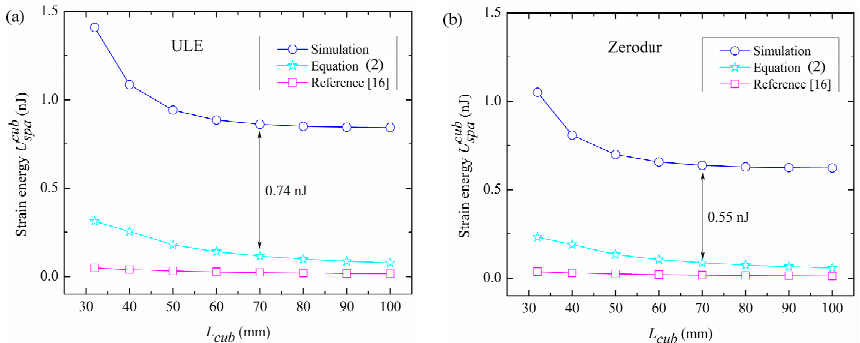
Figure 3. Strain energy as a function of edge L cub of the cubic spacer. The solid blue line with circles represents the simulation results. Magenta solid line with squares presents the analytic estimate according to Equation (2) in Ref. [16]. Cyan solid line with stars presents the analytic estimate according to Equation (2). ( a ) ULE cubic spacer with ULE substrates. ( b ) Zerodur cubic spacer with Zerodur substrates.